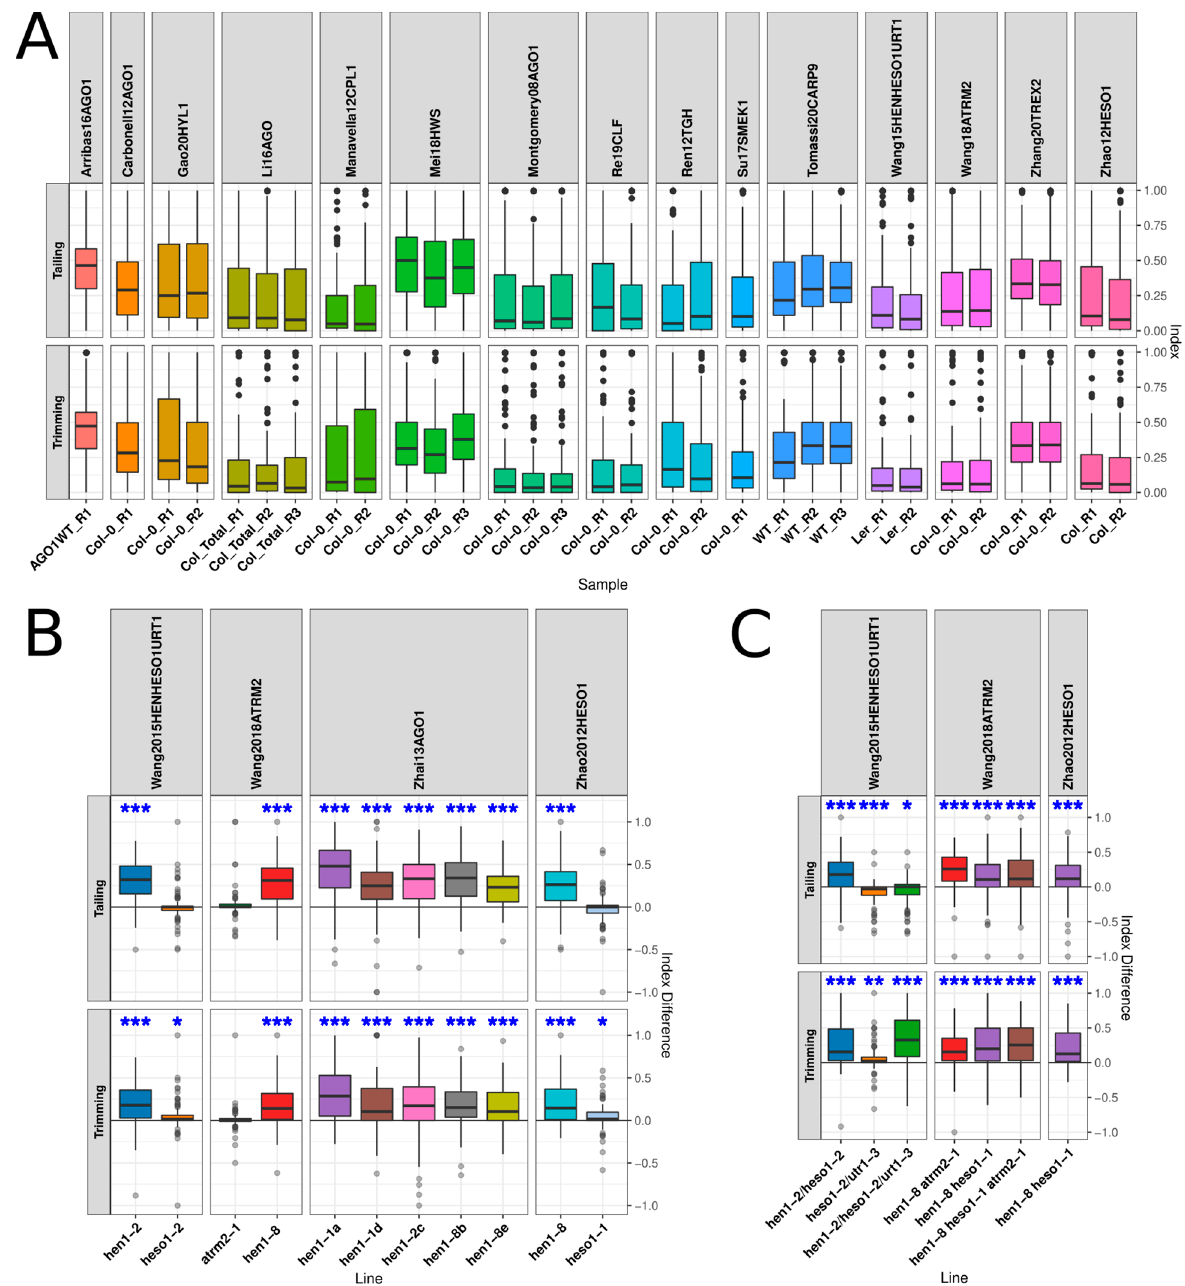
Figure 1. Trimming and tailing index differences enabled compensating for interstudy variability and proved capable of detecting known effects of mutating genes involved in miRNA turnover: ( A ) distribution of trimming and tailing indexes for guide miRNAs in wild type (WT) plants from the different studies analyzed, ( B ) distribution of trimming and tailing index differences (IDs) of guide miRNAs in single mutants of genes known to be involved in miRNA turnover, and ( C ) distribution of IDs of guide miRNAs in doble mutant plants of genes involved in miRNA turnover. Asterisks over the boxplots indicate the results of paired t-tests between the mean index of the line and that of the reference line, paired by miRNA; * p -value below 0.05, ** p -value below 0.01, and *** p -value below 0.001. Tests were grouped by the modification evaluated, trimming or tailing, and p -values were FDR-corrected across all studies analyzed in this work.